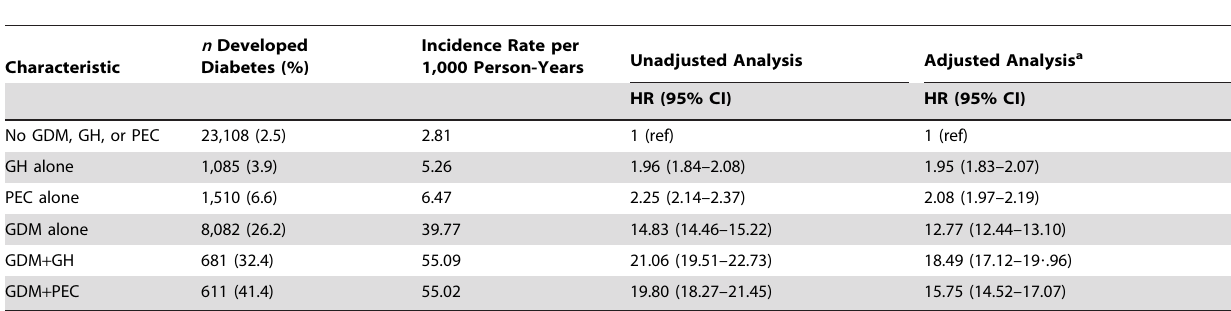
Table 2. Multivariable Cox proportional hazards models evaluating the relationship among preeclampsia, gestational hypertension, and gestational diabetes in the development of